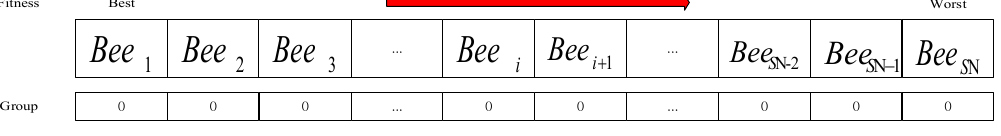
Figure 8. Schematic diagram of bee colony fitness ordering.